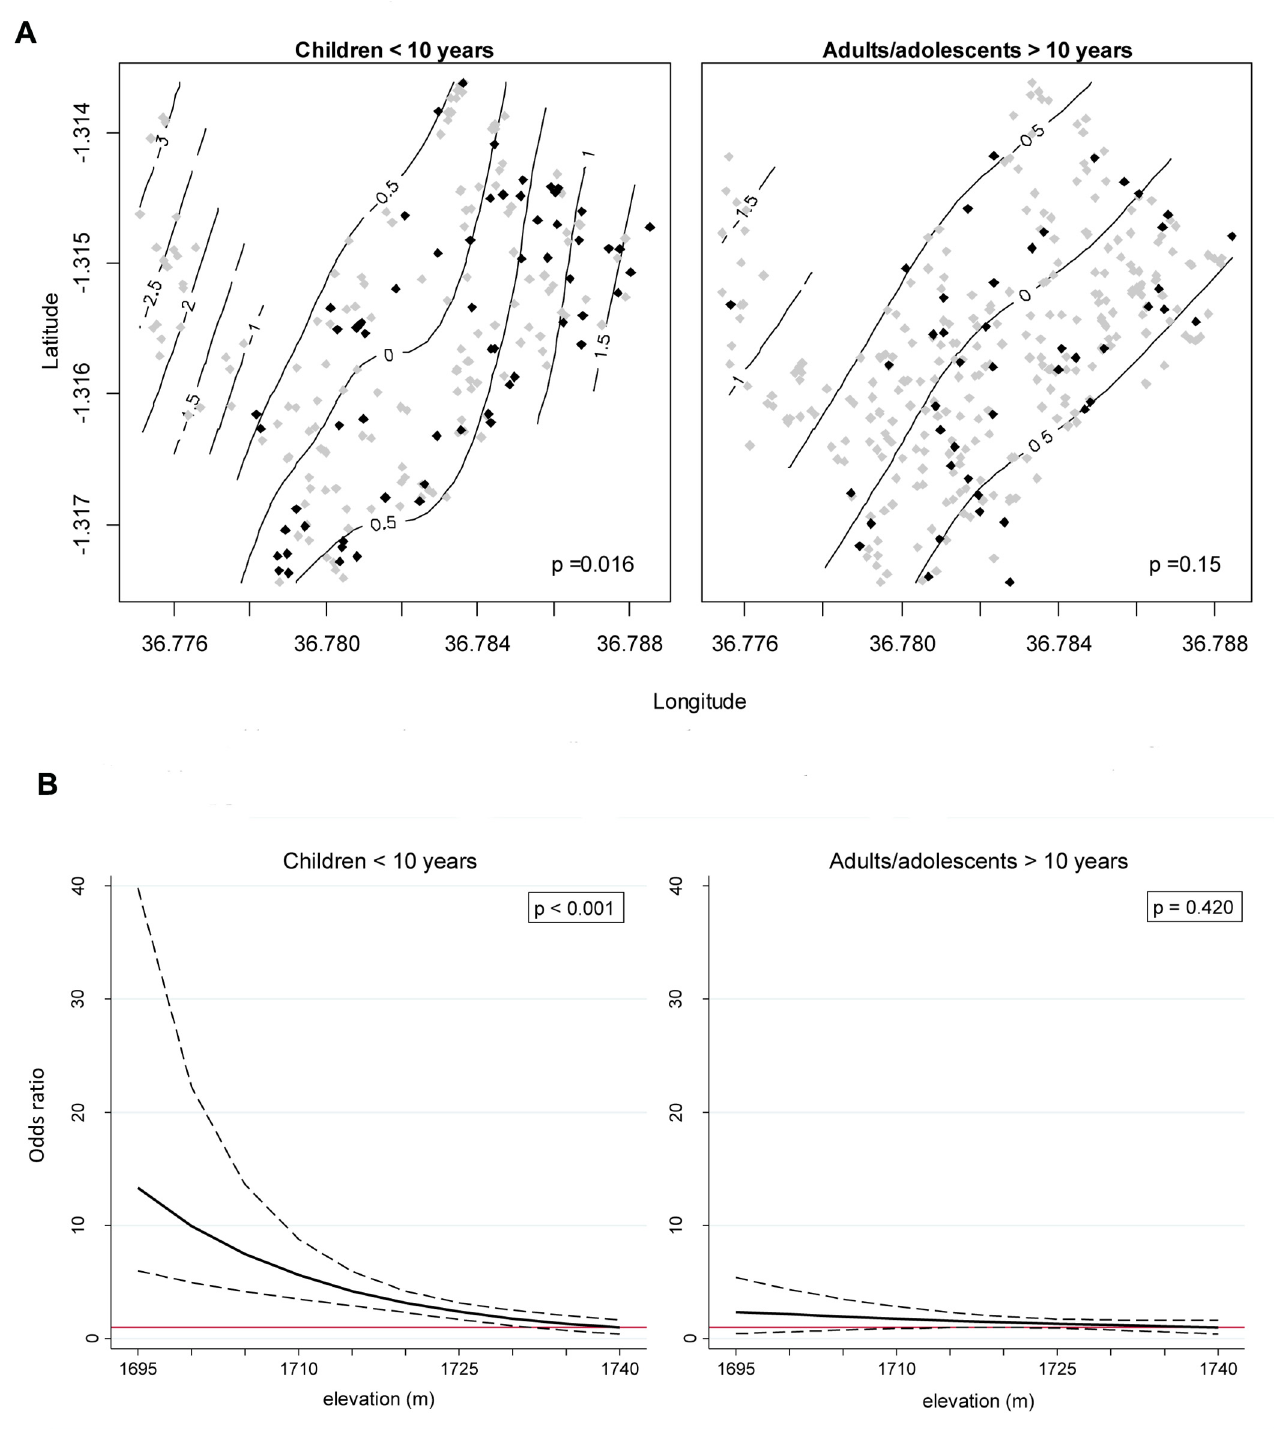
Fig 4. (A) Smoothed log odds (contours) of typhoid fever by age group across the study area, adjusted for age and household size, with cases (black points) and controls (grey points) overlaid. P-values test for significance of the observed spatial pattern in log odds against a homogenous risk surface (i.e., where the log odds is zero at all locations). (B) Adjusted odds ratios from the multi-variate logistic model (Table 2) for the association between elevation and typhoid fever for both children ( < 10 years) and adults/adolescents ( > 10 years), with 95% CI overlaid (dashed lines). Odds ratio of 1 (ref odds = 1740 meters in elevation) indicated by horizontal red